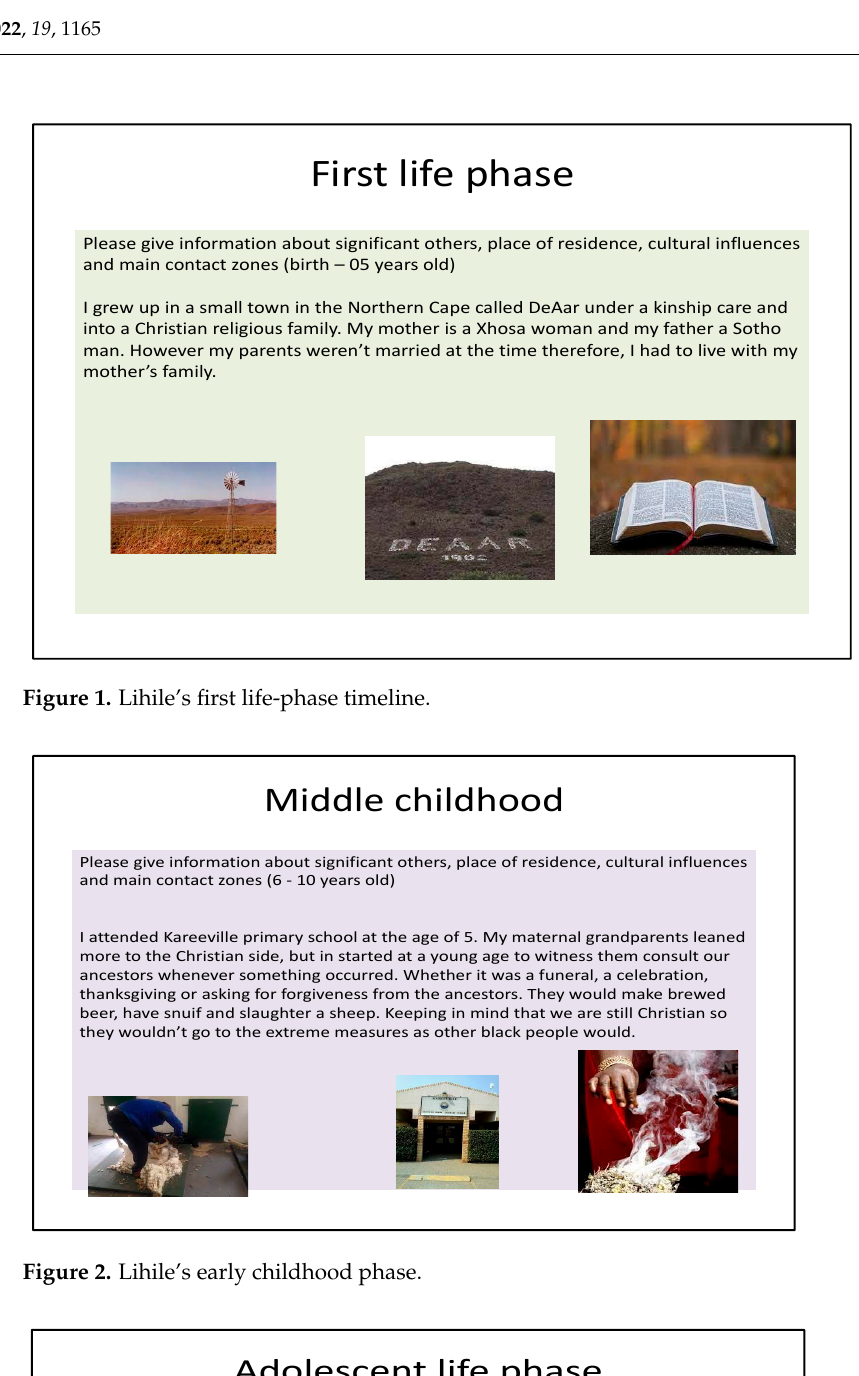
Adolescent life phase